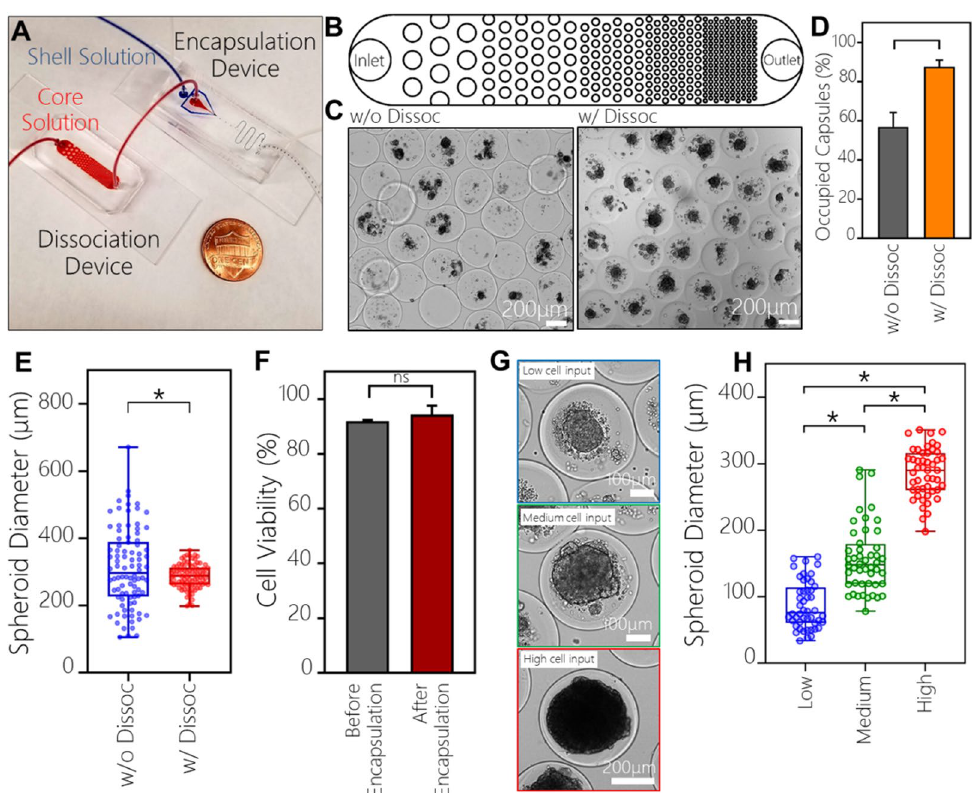
Figure 3. Integration of microfluidic dissociation and encapsulation modules. ( A ) Image of a microfluidic dissociation device interconnected with a flow focusing encapsulation device. Outlet from the dissociation device was connected to the core flow inlet of the encapsulation device. ( B ) Design of the dissociation device consisting of PDMS pillars with pitch ranging from 500 μm at the inlet to 50 μm at the outlet. ( C ) Microcapsules imaged immediately after fabrication. Note the number of blank capsules is lower when dissociation device is used prior to encapsulation. ( D ) Quantification of capsules occupied by cells (n = 100, p < 0.05). ( E ) Size distribution of spheroids after encapsulation with and without the dissociation device (n = 90, spheroids, p < 0.05). ( F ) HUES-8 viability is not affected by the dissociation/encapsulation process. ( G ) Images of encapsulated spheriods of HUES-8 cells created from varying starting cell concentrations. ( H ) Quantiation of spheroid diameters created from different cell inputs: 15 × 10 6 cells mL −1 (low), 30 × 10 6 cells mL −1 (medium) and 60 × 10 6 cells mL −1 (high) (n = 48, p < 0.05). HUES-8 cells were